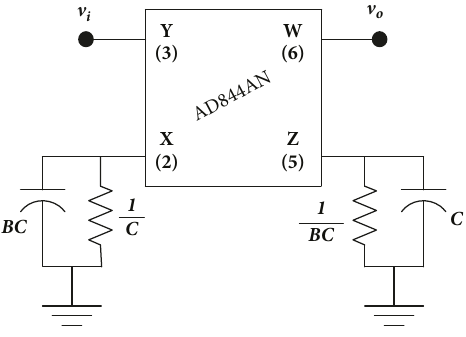
Figure 1: FOI circuit synthesis based on